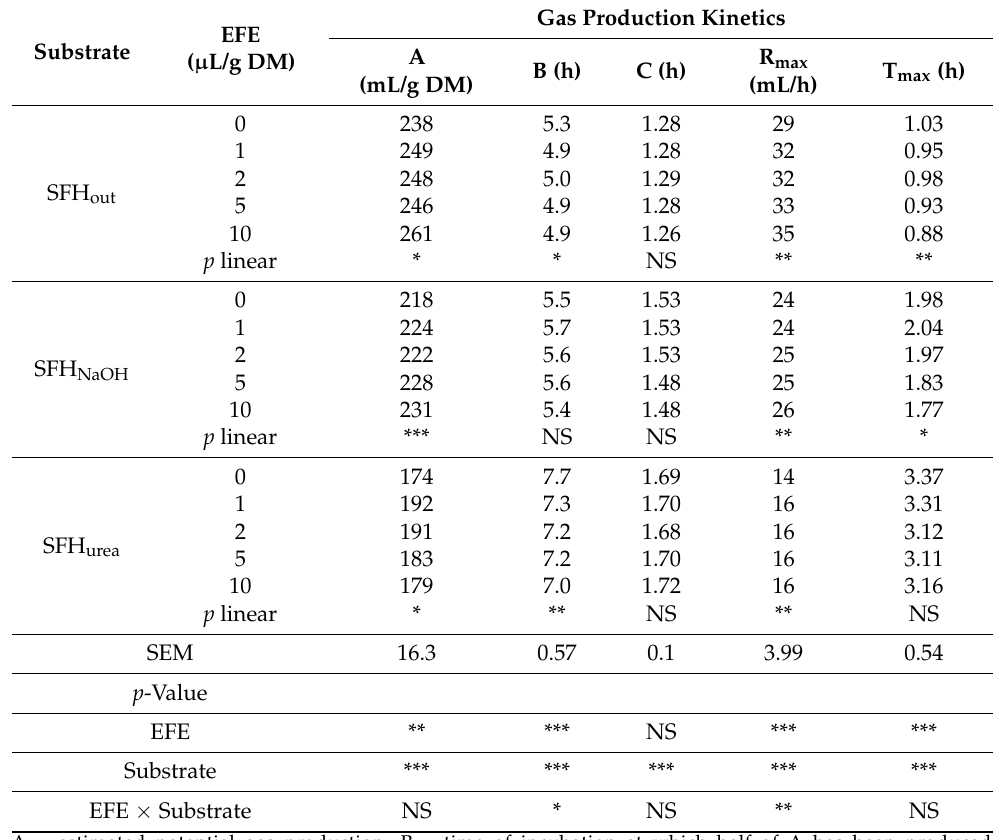
Table 4. Effects of EFE supplemented to pretreated SFH (SFH out , SFH NaOH , SFH urea ) on the kinetics of in vitro gas